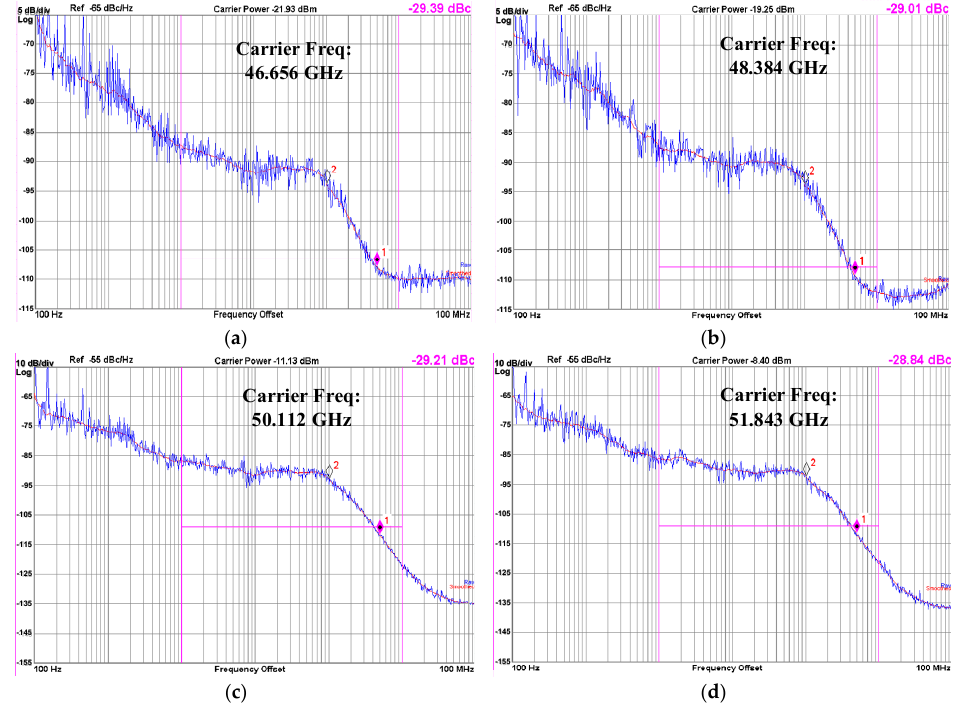
Figure 17. Measured phase noise of the PLL: ( a ) 46.656 GHz; ( b ) 48.384 GHz; ( c ) 50.112 GHz; ( d ) 51.840 GHz.